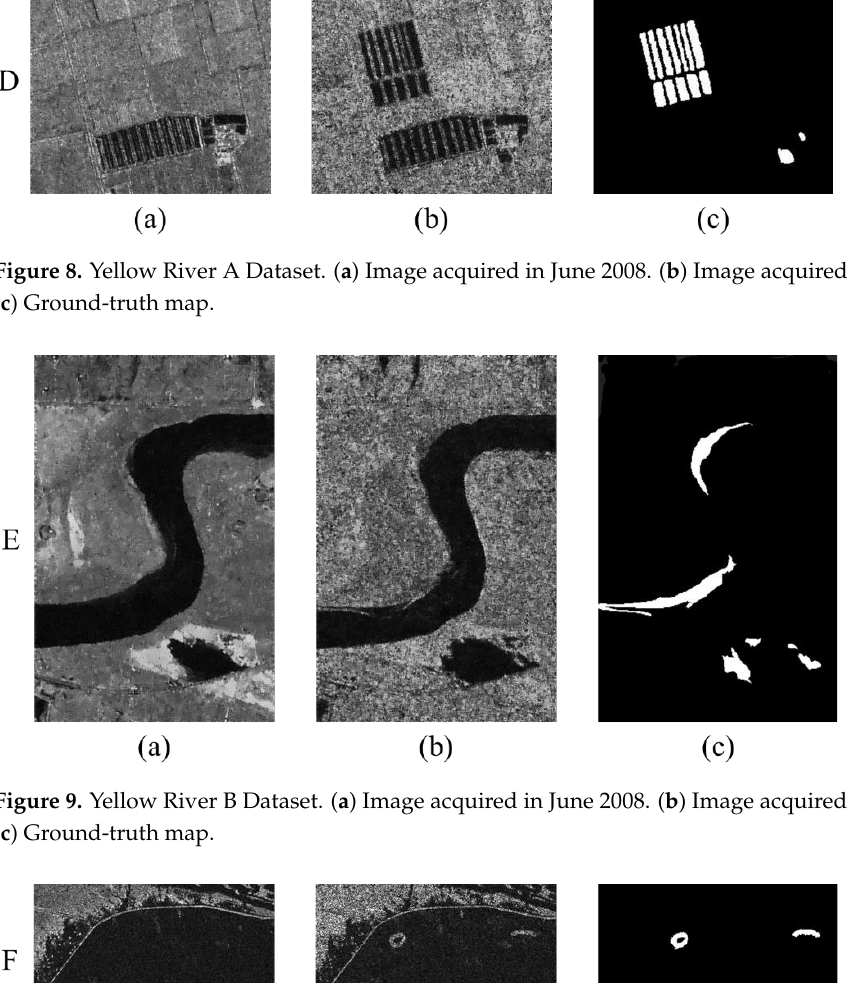
2011. ( c ) Ground-truth map.